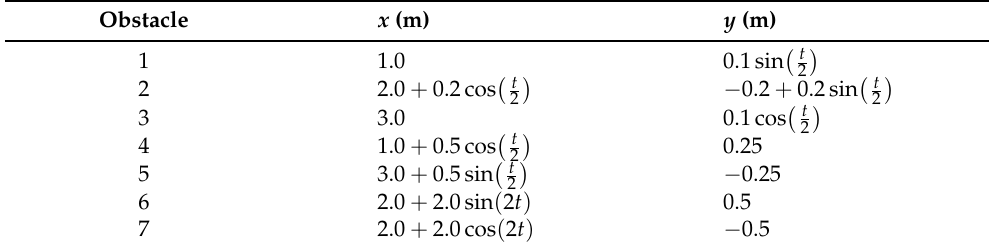
Table 1. Dynamic behavior of obstacles in the test scenario for t ∈ [ 0,15 ] (s).